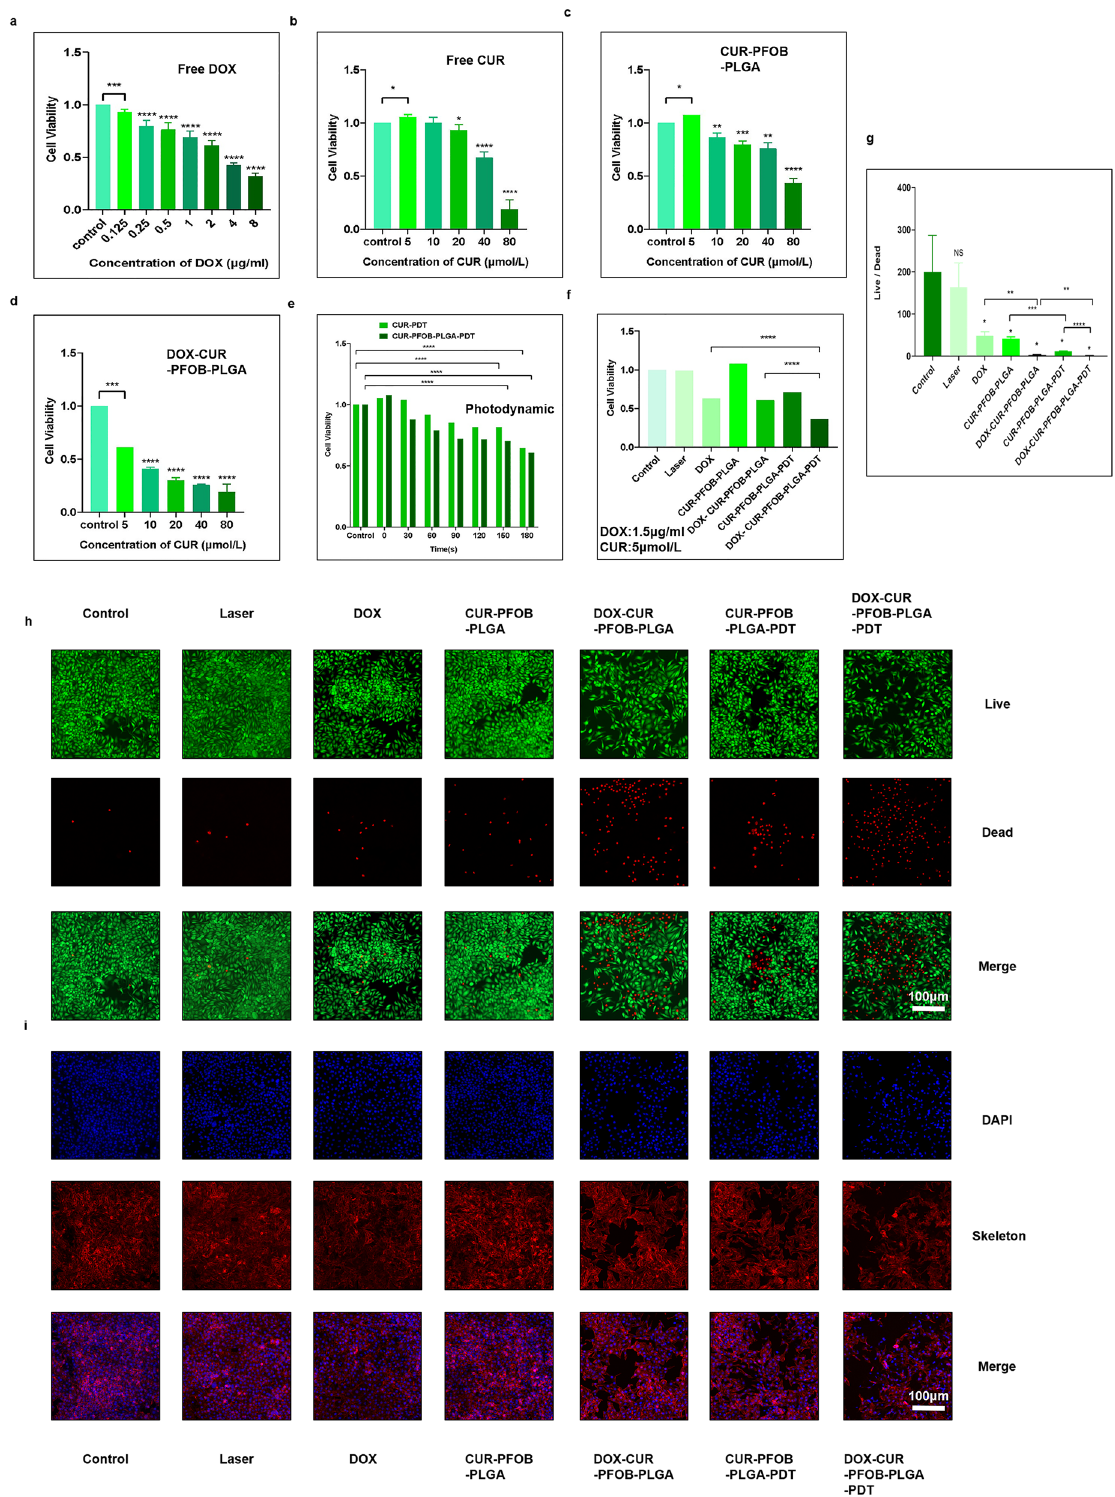
Figure 4. MCF-7 cell viability. ( a ) Effect of 0.125–8 μg /mL DOX on MCF-7 cell viability; ( b ) Effect of 5–80 μmol/L CUR on MCF-7 cell viability; ( c ) Effect of 5–80 μmol/L CUR–PFOB–PLGA NPs on MCF-7 cell viability; ( d ) Effect of 5–80 μmol/L DOX–CUR–PFOB–PLGA NPs on MCF-7 cell viability; ( e ) Effect of 0–150 s laser irradiation in combination with 5 μmol/L CUR or CUR–PFOB–PLGA NPs on MCF-7 cell viability; ( f ) Effect of 1.5 μg/mL DOX, 5 μmol/L CUR, CUR–PFOB–PLGA NPs and DOX–CUR–PFOB–PLGA NPs and 150 s laser irradiation alone or in combination on the viability of MCF-7 cells; ( g ) The ratio of the counts of live cells to dead cells in MCF-7 cells; ( h ) Live/Dead analysis of MCF-7 cells under LSCM. (Live cells were stained green while dead cells appeared red.); ( i ) The LSCM images of MCF-7 cells (The cytoskeleton was stained in red and the nucleus was blue.). (NS, no significant difference; * P < 0.05; ** P < 0.01; *** P < 0.001; **** P <